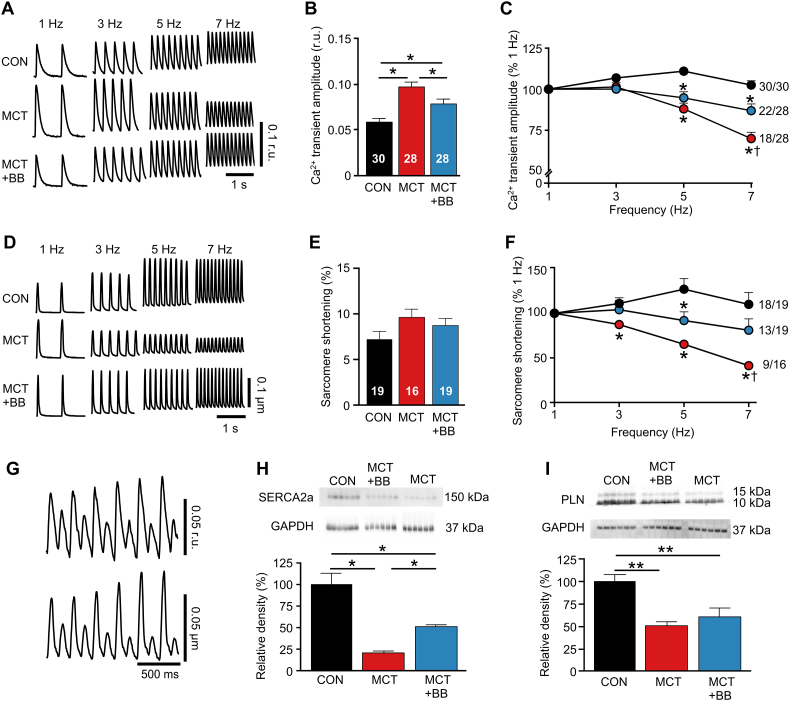
BB improved RV myocyte contraction-frequency relationship. A Representative traces of Ca2+ transients at different stimulation frequencies. B Ca2+ transient amplitude of RV myocytes field stimulated at 1 Hz was greater in MCT than CON and MCT + BB. C The Ca2+ transient amplitude remained stable in CON cells as pacing frequency was increased, whereas it progressively declined in MCT. Ca2+ transient amplitude was greater in MCT + BB than MCT at 7 Hz. The number of cells that could be paced at 7 Hz is shown. D Representative traces of unloaded sarcomere shortening in a separate group of cells without Fura-4 at different stimulation frequencies. E Shortening at 1 Hz was not different between groups. F Changes in sarcomere shortening with increased stimulation frequency reflected the changes in Ca2+ transient amplitude. Shortening in MCT + BB cells was greater than MCT at 7 Hz. G Example recording of a MCT cell unable to regularly pace at 7 Hz due to the emergence of Ca2+ release (upper panel) and sarcomere shortening (lower panel) alternans. H,I Representative Western blots of SERCA2a, PLN and GAPDH. Note difference in group orders between blots (upper panels) and data (lower panels). H There was a reduction in protein expression of SERCA2a in MCT RV that was partially restored by BB. I There was a reduction in protein expression of PLN in the RV of MCT and MCT + BB hearts. N = 6 rats per group. B,E,H,I one-way ANOVA, C,F two-way ANOVA. *P < .05, **P < .01 vs CON, †P < .05 vs MCT + BB.